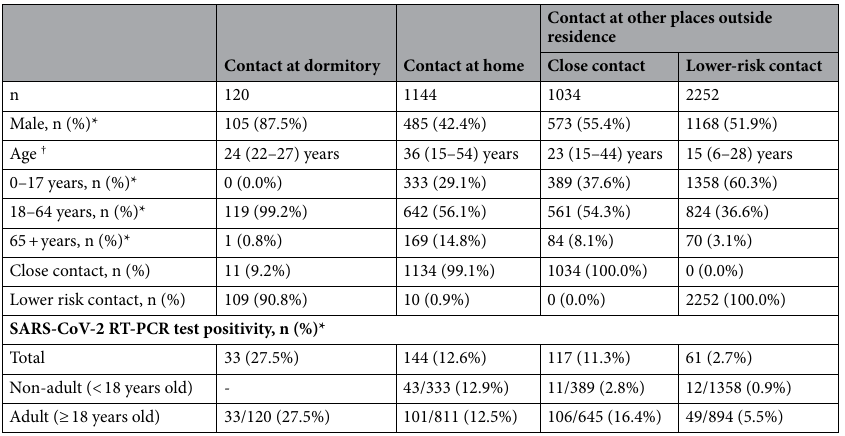
Table 1. Demographic features of the participants by the place of contact with COVID-19 patients. Close contact was defined by the existence of the following four criteria: (1) contact with a patient between 2 days before and 14 days after the onset of symptoms, (2) no usage of masks, (3) distance within 1 m, and (4) more than 15 min of contact. Lower risk contact was defined as presence in the same facility as COVID-19 patients, but without fulfilling the above-described criteria of close contact. COVID-19, coronavirus disease; n.a., not available; RT-PCR, reverse transcription-polymerase chain reaction; SARS-CoV-2, severe acute respiratory syndrome coronavirus-2. *Numbers and percentages in the column (i.e., among subjects in each contact level group); † median and interquartile range (25–75 percentiles).